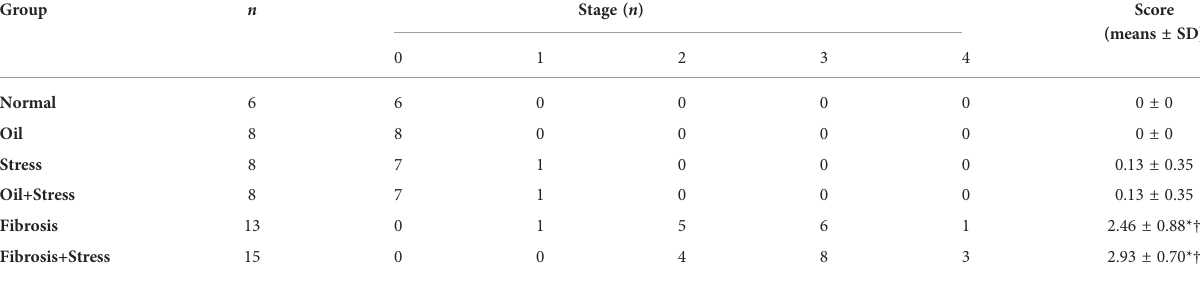
TABLE 1 Scores of hepatic fi brosis staging by Masson